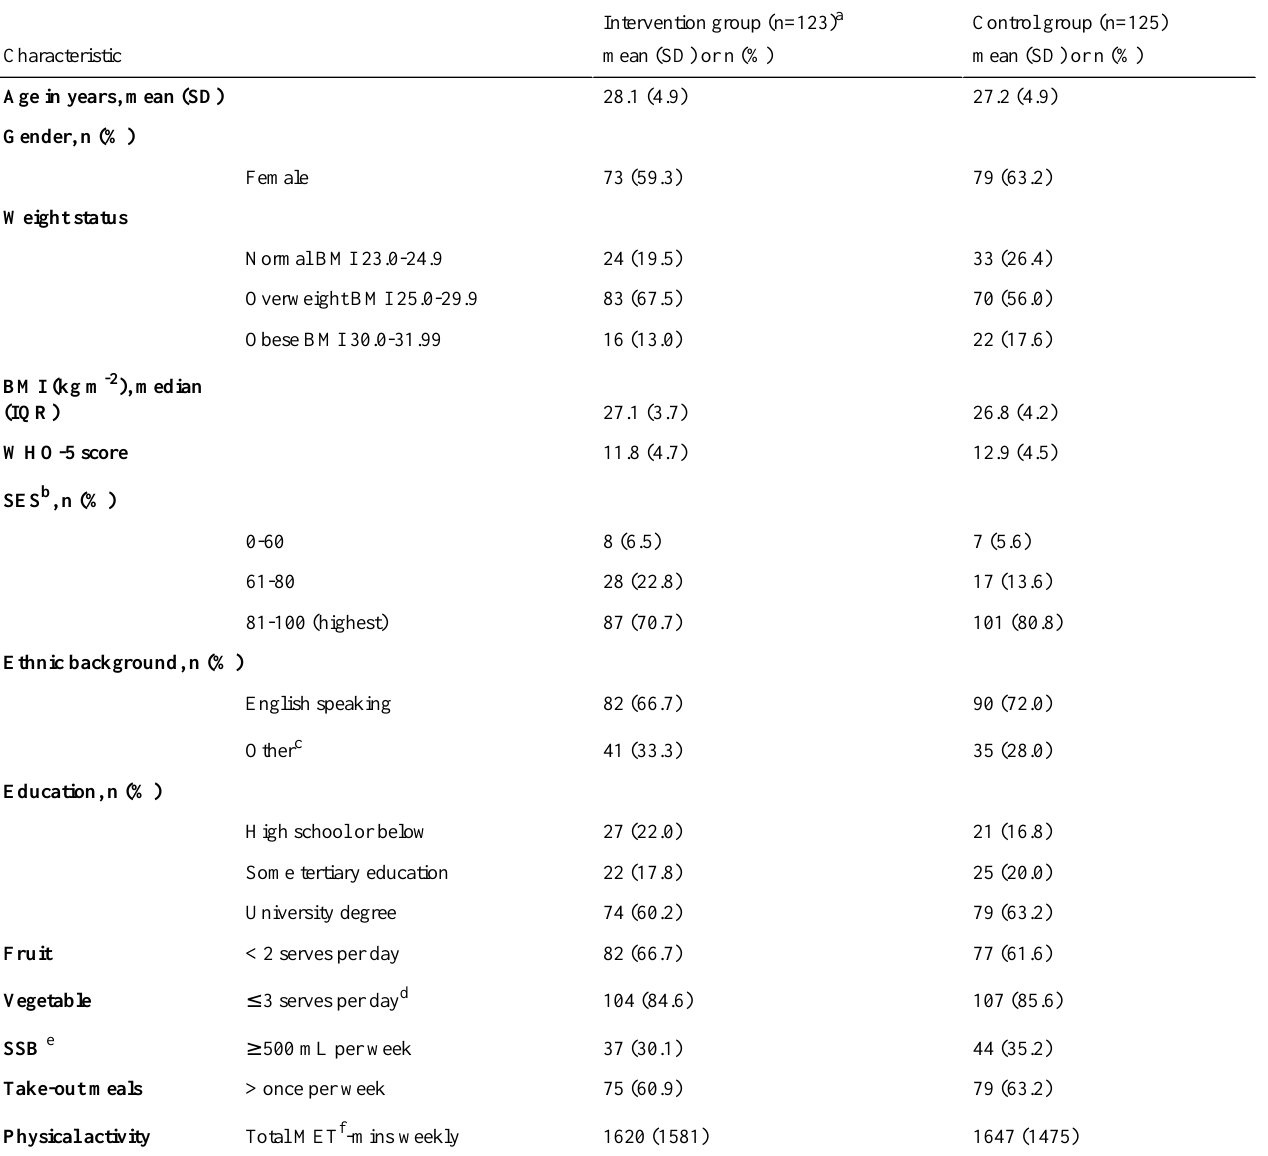
Table 1. Characteristics and baseline behaviors of participants in the TXT2BFiT trial.